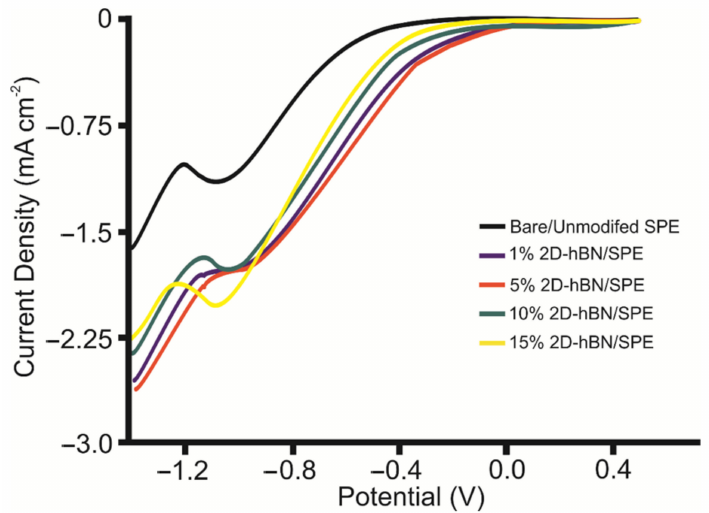
Figure 2. Typical LSVs recorded in an oxygen saturated 0.1 M H 2 SO 4 solution using unmodified (black line), 1% 2D-hBN (blue line), 5% 2D-hBN (red line), 10% 2D-hBN (green line) and 15% 2D-hBN (yellow line) incorporated SPEs. Scan rate: 100 mV s − 1 (vs. SCE).